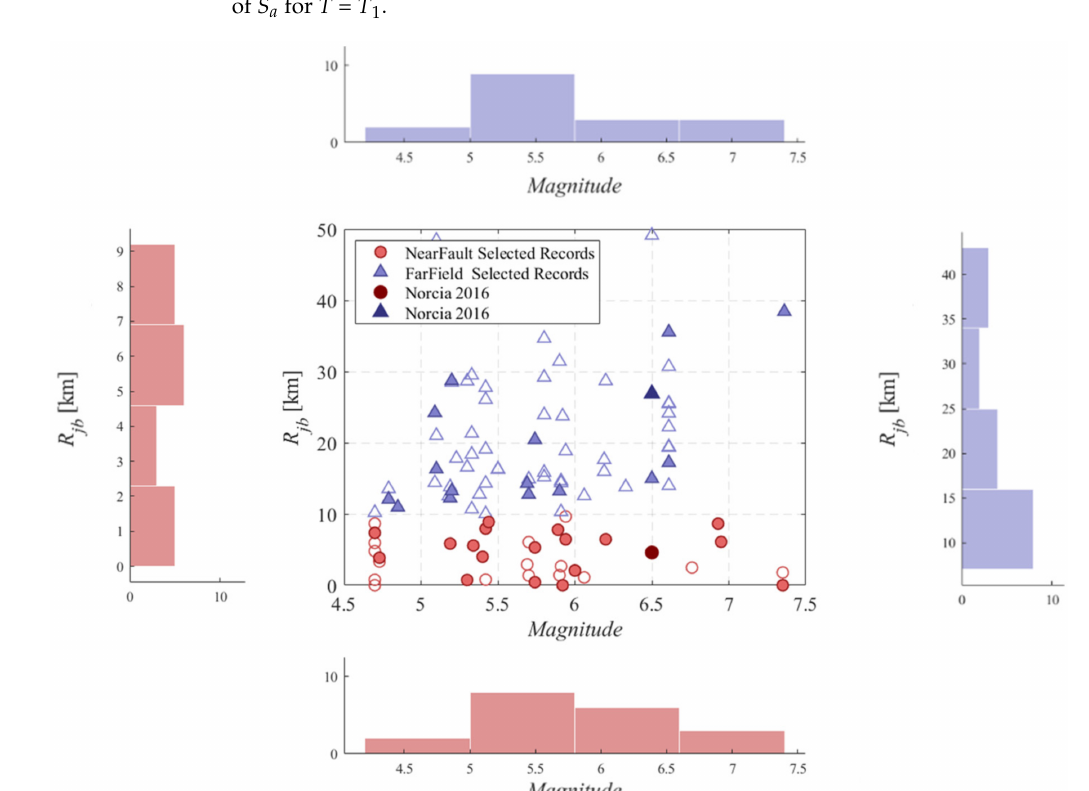
Figure 2. M w magnitude–R jb distance scatter diagrams of the two subsets, Sel. 1 NF and Sel. 7 FF